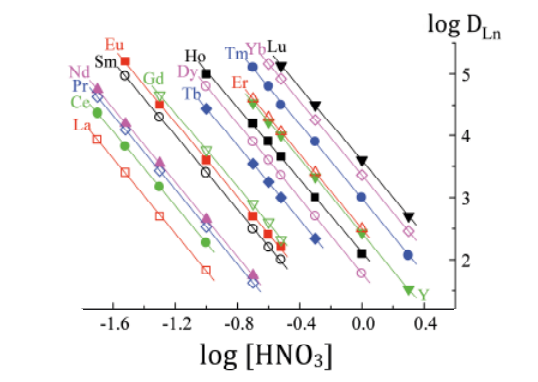
Figure 3. The effect of HNO concentration in the aque- 3 ous phase on the adsorption of Ln(III) by the FB-D2EHPA sorbent. CHA = 1.0 mmol g -1 . The sizes of the points represent error bars. Slope: -3.01 ± 0.12 (Y), -3.0 ± 0.12 (La), -2.98 ± 0.13 (Ce), -2.98 ± 0.13 (Pr), -3.03 ± 0.15 (Nd), -2.97 ± 0.14 (Sm), -2.98 ± 0.15 (Eu), -3.03 ± 0.16 (Gd), -3.0 ± 0.15 (Tb), -3.02 ± 0.17 (Dy), -2.91 ± 0.19 (Ho), -2.97 ± 0.16 (Er), -3.03 ± 0.17 (Tm), -2.98 ± 0.15 (Yb), and -2.94 ± 0.18 (Lu).